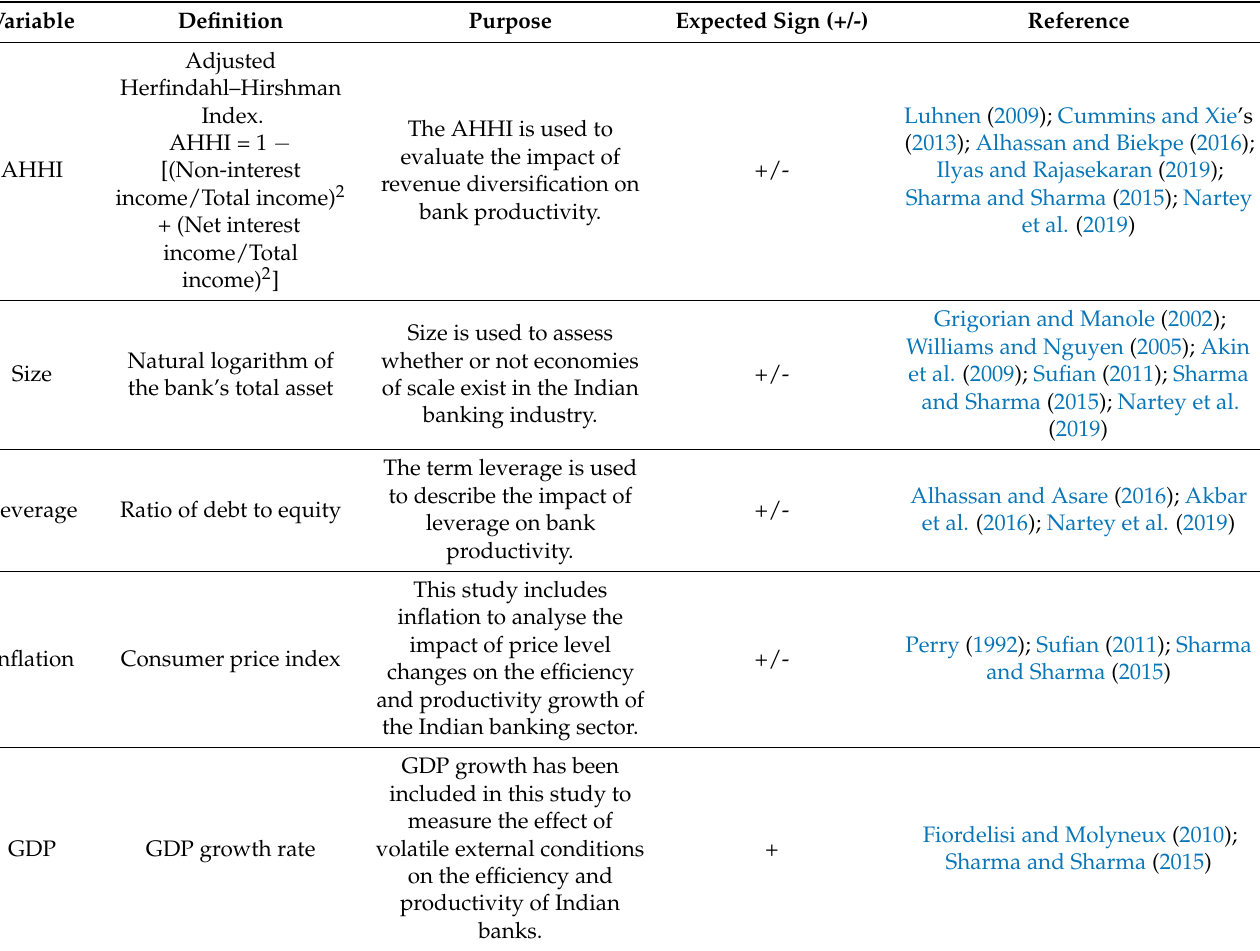
Table 1. Control variables and